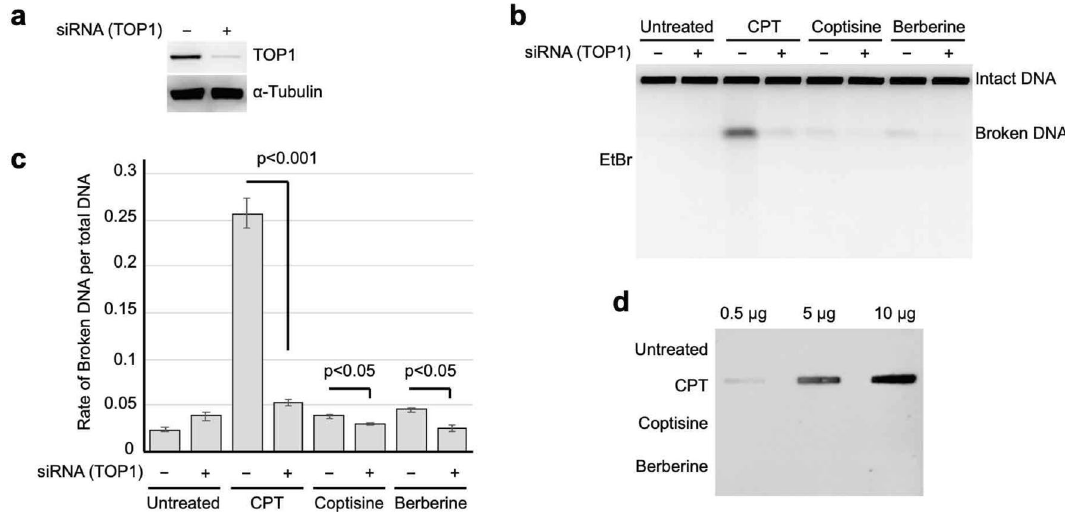
Figure 3. Analysis of Topo I inhibition by BIAs in vivo. ( a ) Western blot analysis of Topo I after transfection with siRNA against the Top1 gene. ( b ) PFGE analysis of DSB accumulation after treatment with transient Topo I depletion by siRNA combined with berberine and coptisine. ( c ) Quantification of broken DNA per total DNA after treatment with transient Topo I depletion by siRNA combined with berberine and coptisine. The means and SEs were determined from four independent experiments. ( d ) Analysis of the accumulation of the Topo I-DNA complex by ICE assay. Following the manufacturer’s recommended protocol, the cells were treated with 50 μM CPT, coptisine, and berberine, and the Topo I-DNA complexes were visualized by immunoblotting using an anti-Topo I